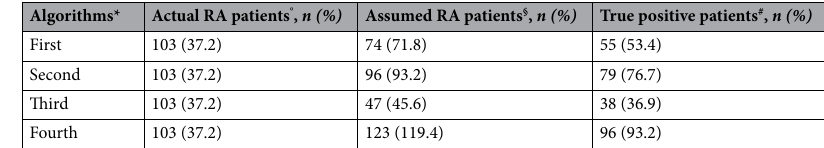
Table 1. Distribution of RA patients selected through the four algorithms: the main analysis. *Out of patients with the first supply of bDMARD from 2014 to 2016 and at least one record of visit at the Rheumatology Unit of Pisa University Hospital from 2013 to the index date, we tested the performance of four index tests (algorithms): First) RA according to hospital discharge records or emergency department admissions (ICD-9 code, 714*); Second) RA according to exemption code from co-payment (006); Third) RA according to hospital discharge records or emergency department admissions (ICD-9 code, 714*) AND RA according to exemption code from co-payment (006); Fourth) RA according to hospital discharge records or emergency department admissions (ICD-9 code, 714*) OR RA according to exemption code from co-payment (006). °The actual diagnosis of RA was that recorded in the medical chart (reference). § the assumed diagnosis was the RA diagnosis recorded in the hospital discharges (regardless of primary or secondary) and emergency department admissions or the co-payment exemption code related to RA in HAD. # True positive patients: These were assumed RA patients in the HAD with actual RA diagnosis in the reference. bDMARD biologic disease modifying antirheumatic drug, HAD Healthcare Administrative Database, ICD-9 international classification of diseases 9th revision, n number; RA rheumatoid